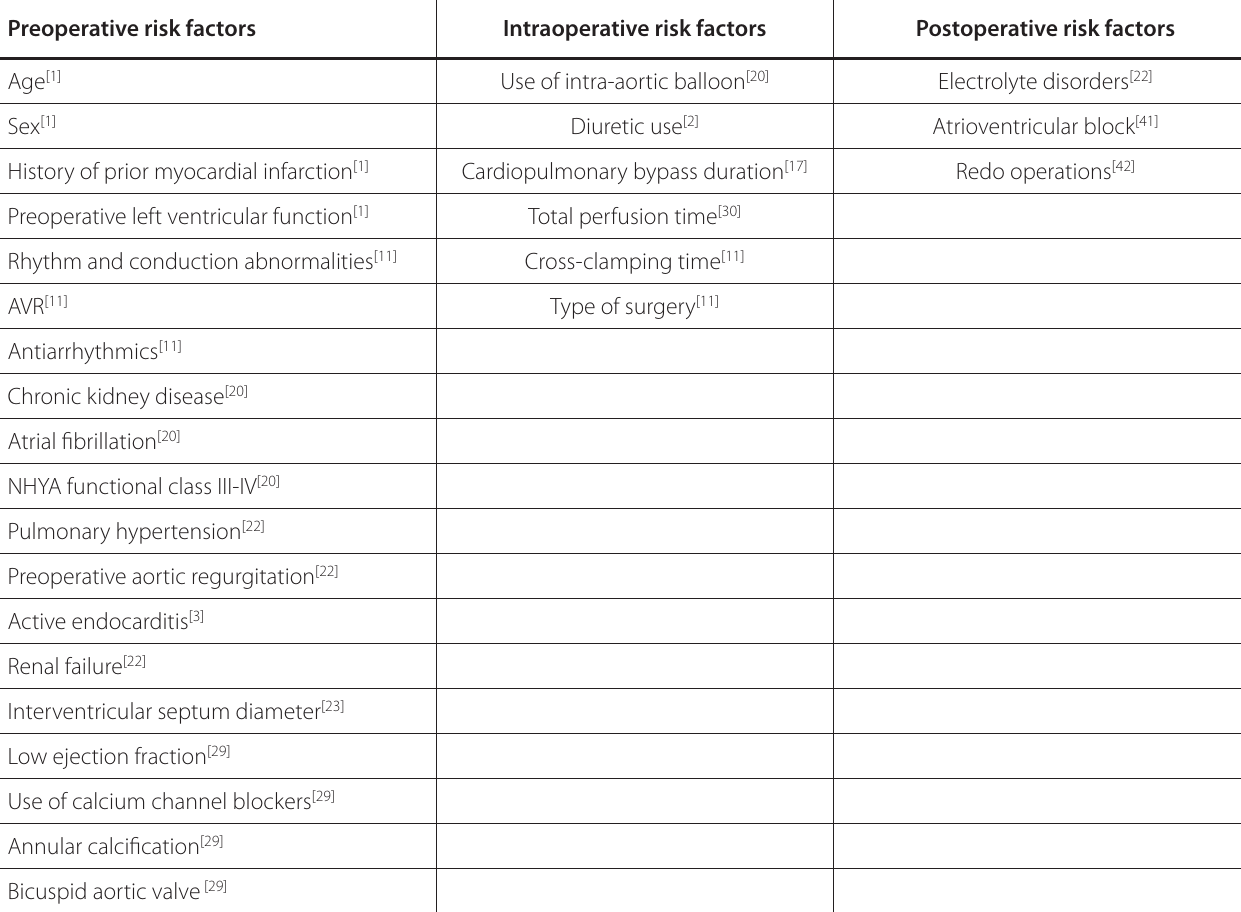
Table 1 . List of preoperative, intraoperative, and postoperative risk factors. Preoperative risk